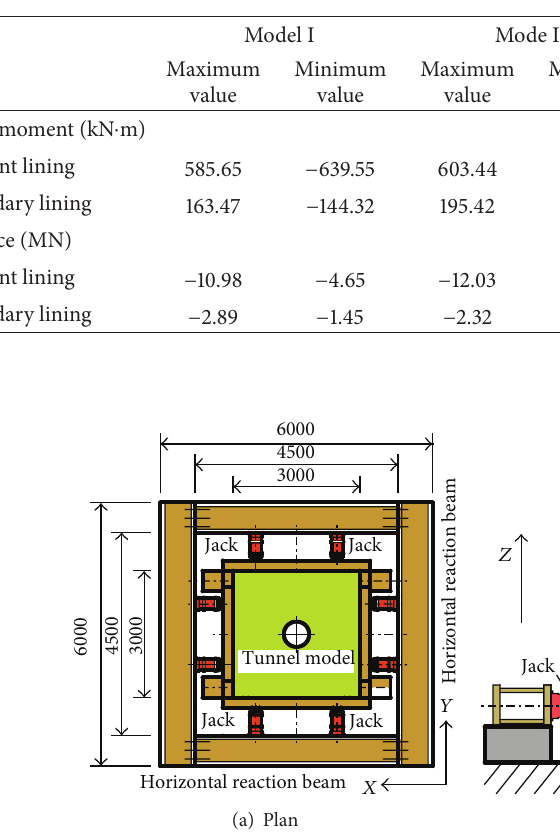
Table 4: Comparison on extreme internal forces between numerical and test results.